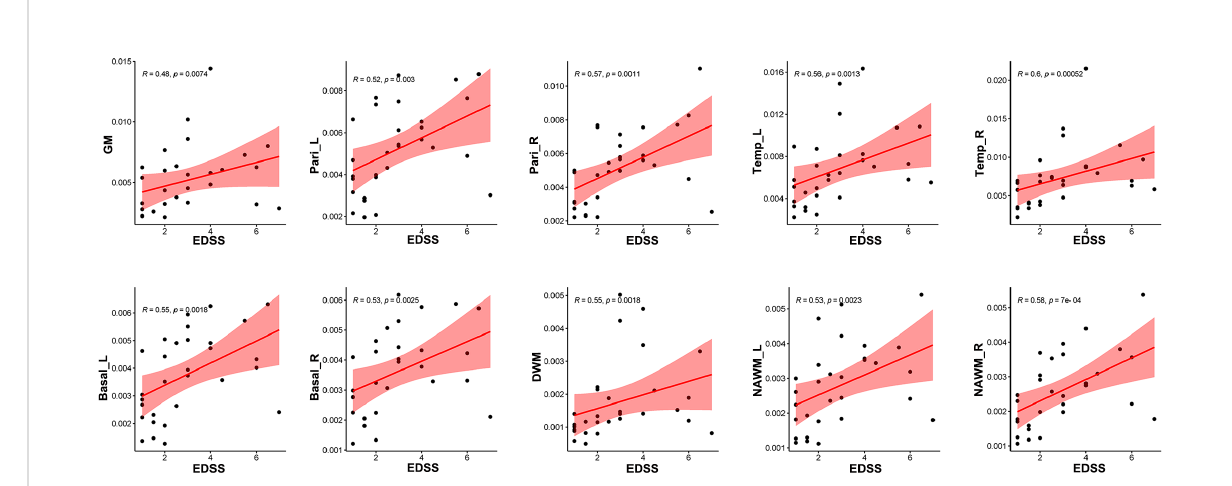
FIGURE 7 Correlation between EDSS scores and CBF in different regions. CBF in global GM, bilateral parietal lobes, bilateral temporal lobes, bilateral basal ganglia, DWM and NAWM were positively related with EDSS